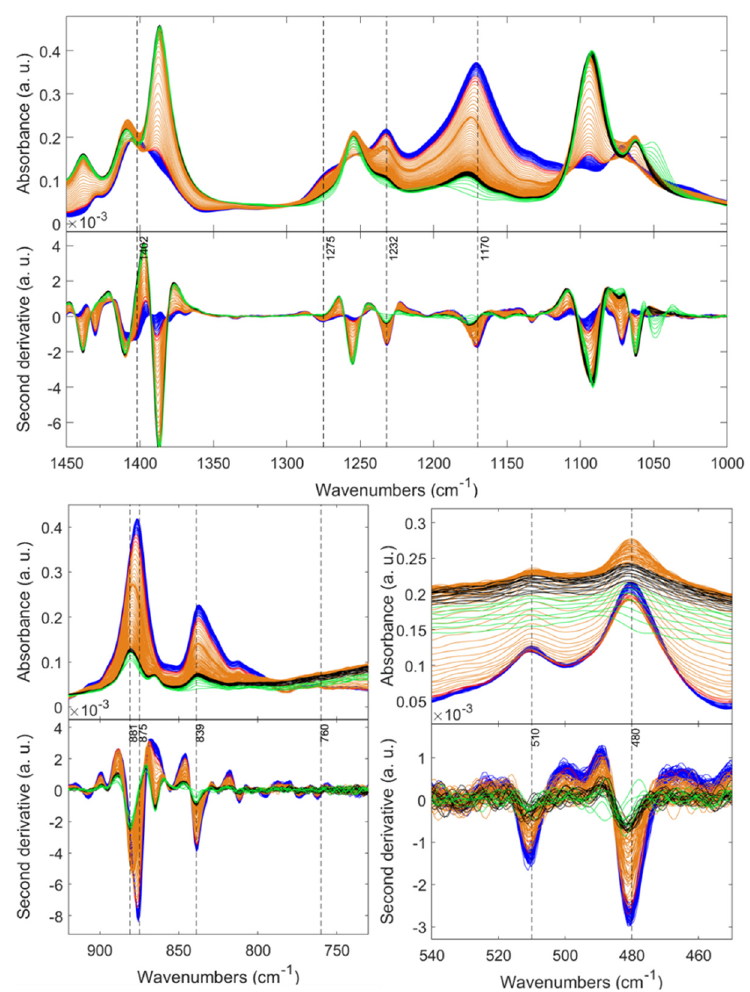
Figure 7. In situ FTIR spectra of the P12E0.2H1.5 solution during the cooling–gelation process (80 °C to RT). For appreciation reasons, the patterns were colored by stages from the beginning to the end: green, black, orange, red, and blue.